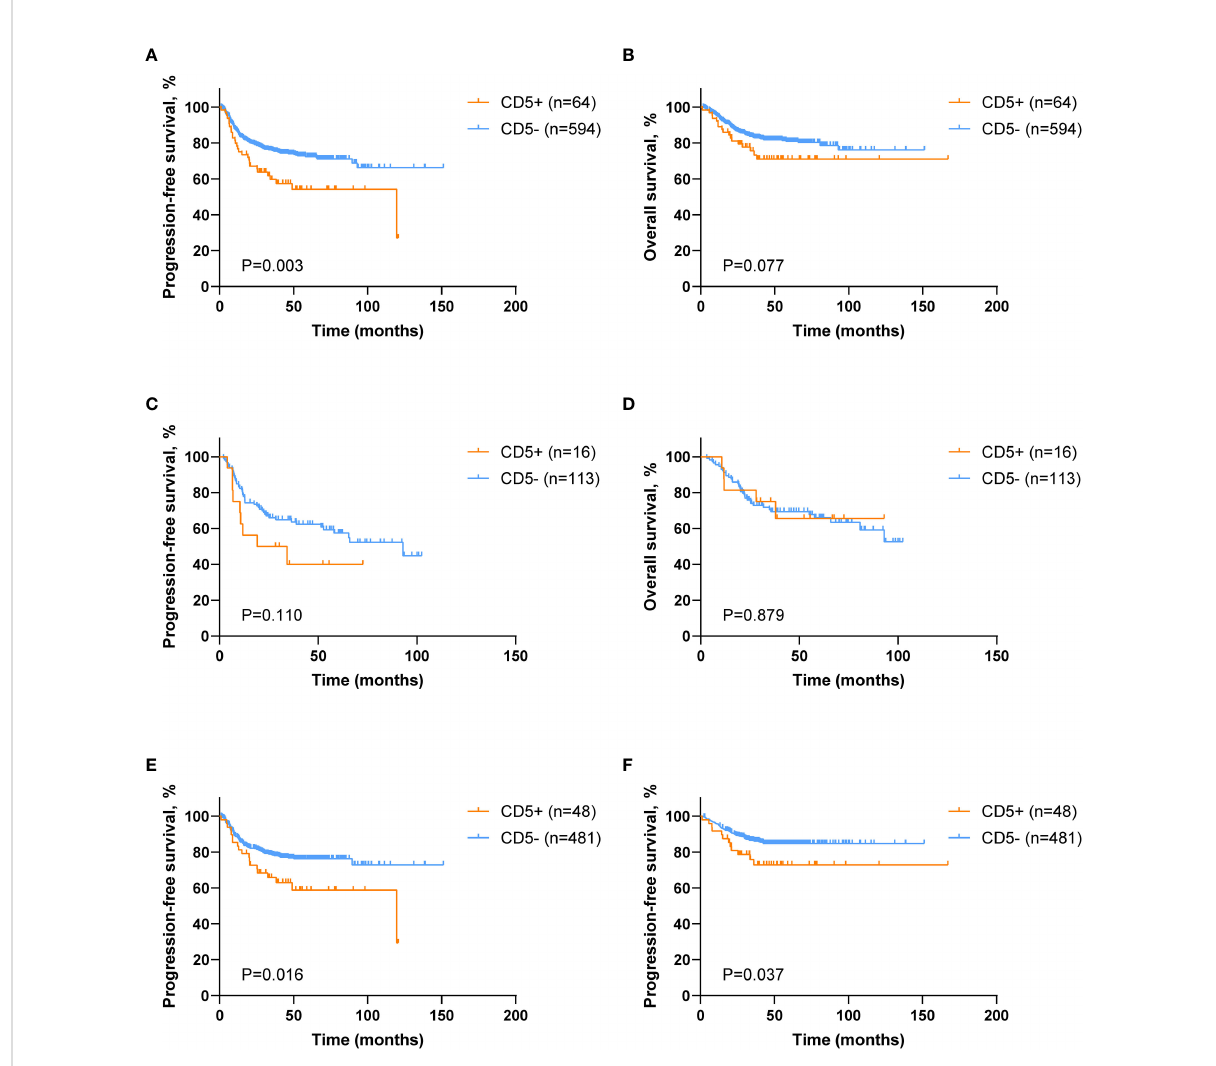
FIGURE 2 Survival analysis of DLBCL patients according to CD5 positivity. (A, B) Kaplan – Meier survival curves of progression-free survival (PFS) and overall survival (OS) comparing CD5+ (n = 64) and CD5 − (n = 594) DLBCL patients. (C, D) Kaplan – Meier survival curves of PFS and OS in CD5+ (n = 16) and CD5 − (n = 113) double expressor (DE) DLBCL patients. (E, F) Kaplan – Meier survival curves of PFS and OS in CD5+ (n = 48) and CD5 − (n = 481) non – double expressor (non-DE) DLBCL